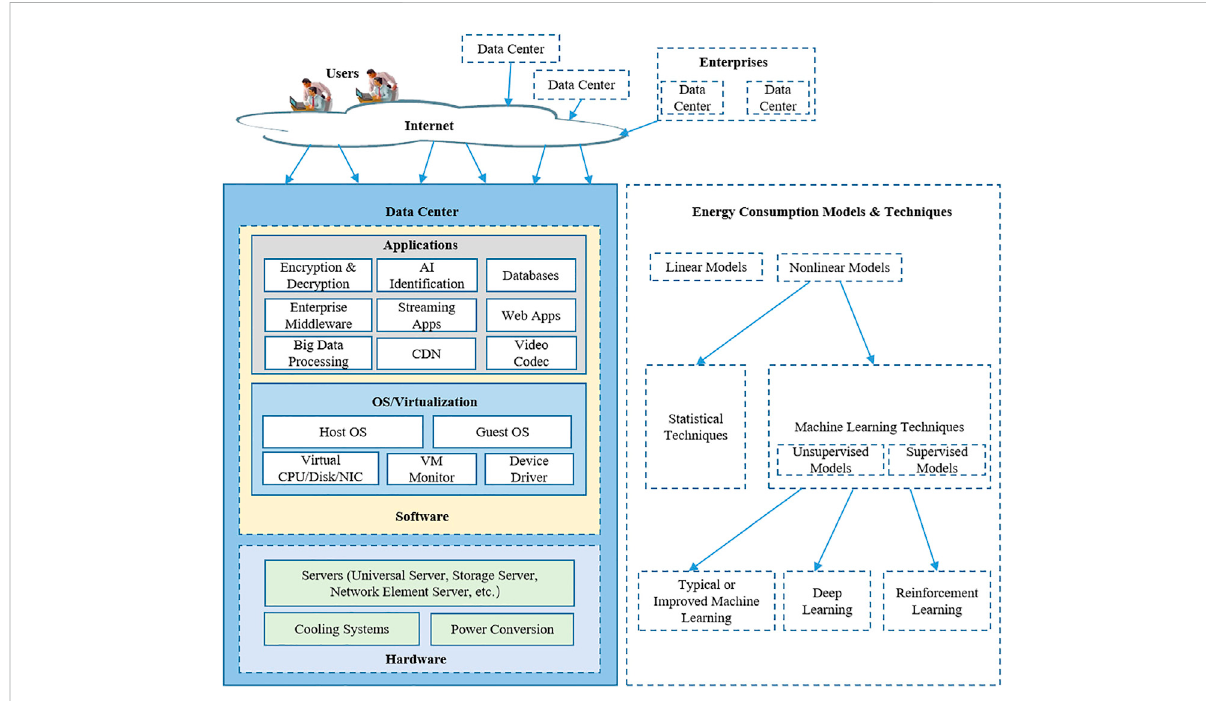
FIGURE 1 The general layout of the data center energy consumption modeling and forecasting